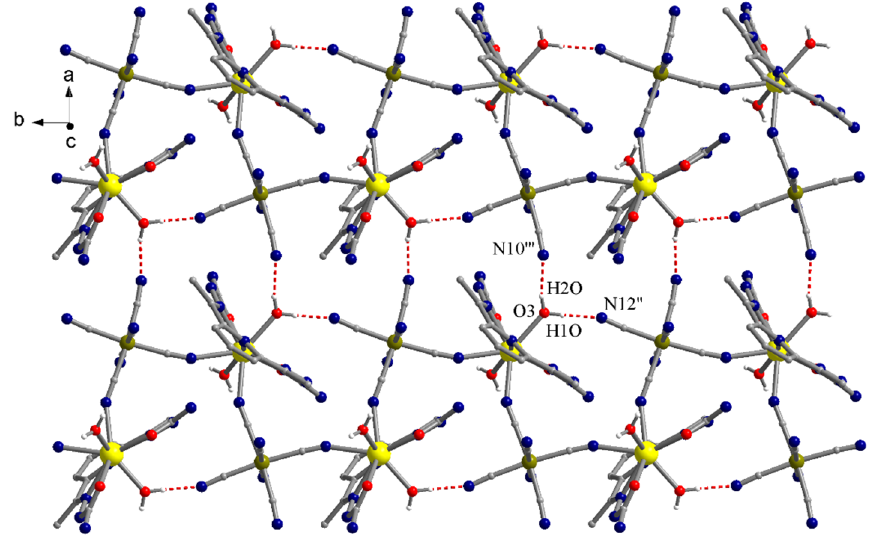
Figure 5. View along the crystallographic c axis of the packing diagram of compound 2 DyFe show- ing a supramolecular layer (symmetry codes: ” = x, − 1 + y, z; ”’ = 2 − x, − 0.5 + y, 1.5 − z). a supramolecular layer (symmetry codes: (cid:48)(cid:48) = x, − 1 + y, z; (cid:48)(cid:48)(cid:48) = 2 − x, − 0.5 + y, 1.5 −